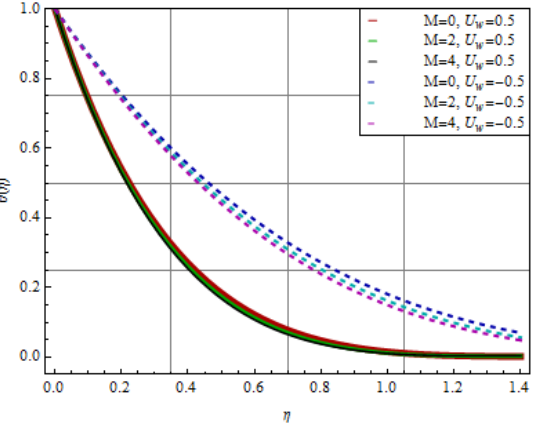
Fig. 16: The temperature distribution for alumina-sodium alginate nanofluid for different values of unsteadiness and wall transpiration parameters with M = 1, ε = 0, λ = 1, Pr = 6.2, ϕ =